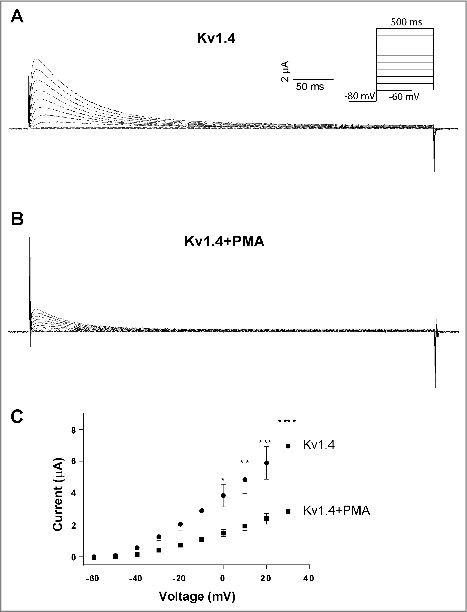
PKC activation promote reduced Kv1.4 currents. TEVC recordings of Xenopus laevis oocytes expressing Kv1.4 channels. Representative current traces of Kv1.4 currents following depolarization steps in control oocytes (A) and from oocytes treated with 100 nM of the PKC activator PMA (B). Insert: Step protocol. (C) Current-voltage relationship of Kv1.4 currents from control and PMA-treated oocytes. PMA significantly down-regulated the current level by 59%. Kv1.4 (n = 10) and Kv1.4+PMA (n = 7).